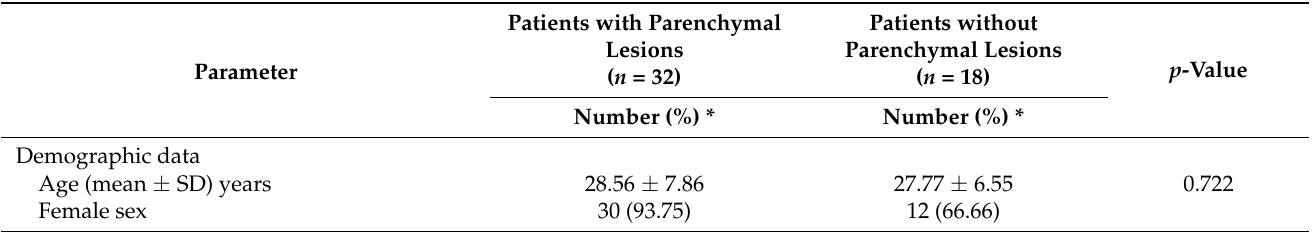
Table 2. Comparison of demographic data, clinical characteristics, and risk factors in patients with or without parenchymal lesions on CT scan ( n =